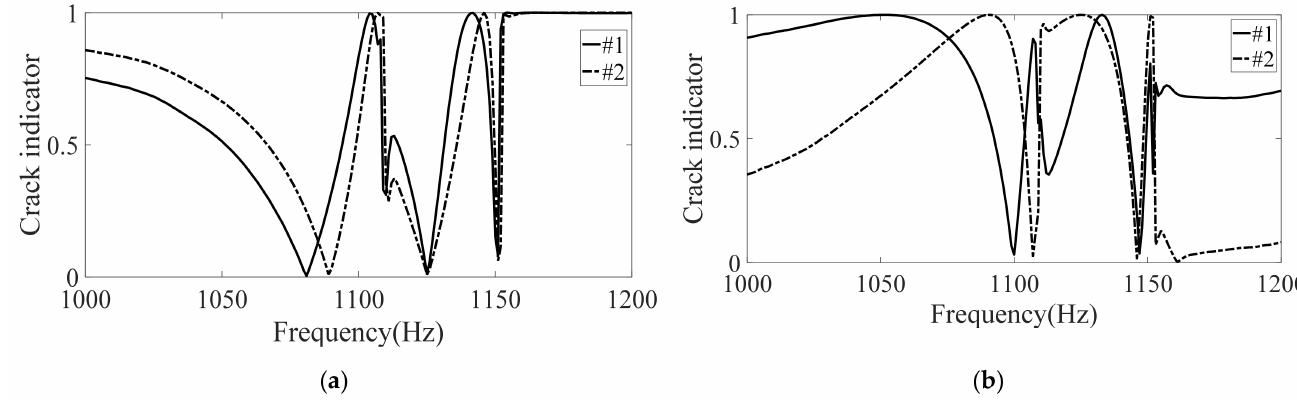
Figure 9. Crack indicator in X-Y plane (front): ( a ) frequency response function and ( b ) acceleration only.